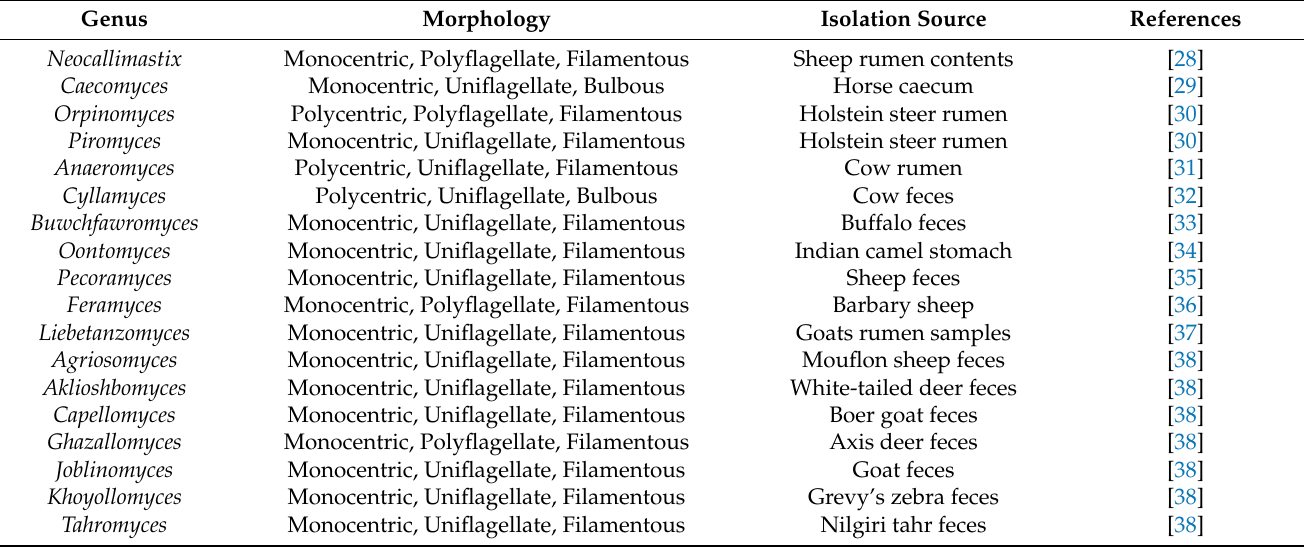
Table 1. The characterized morphological features and isolation source of anaerobic fungi